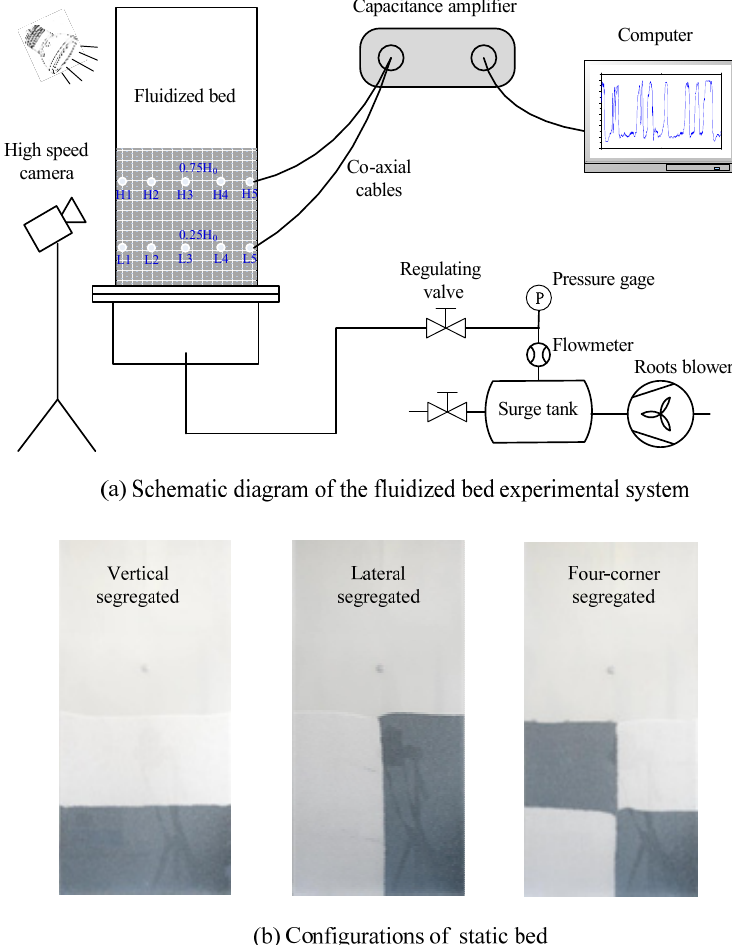
Figure 3. The fluidized bed system. ( a ) Schematic diagram of the fluidized bed experimental system. ( b ) Configurations of static bed. Binary solids, that is, silicon carbide particles and quartz sands with an equal diameter of 0.77 mm and a density ratio of 0.85 are used to study the lateral mixing property. The height of the static bed is 30 cm. In the present research, the following three types of static bed whose configurations, illustrated in Figure 3b, were used.